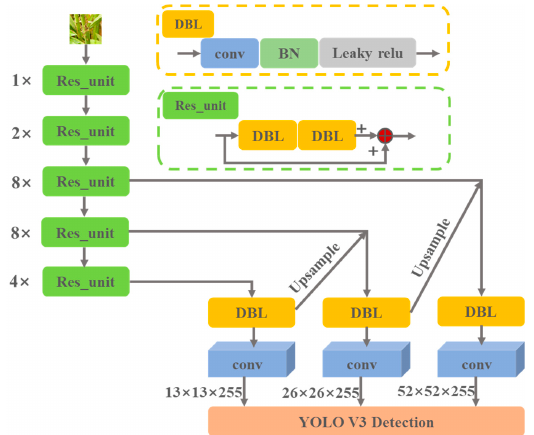
Figure 2. Structure diagram of Yolo V3. DBL: Darknetconv2d_BN_Leaky, BN: Batch Normalization, conv: convolution. First, the input image is divided into 13 × 13 cells. Then, each cell will generate detec- tion boxes, which are each composed of a five-dimensional prediction parameter, includ- ing the center point coordinate ( ) x,y , width and height ( ) w,h , and confidence score i s .